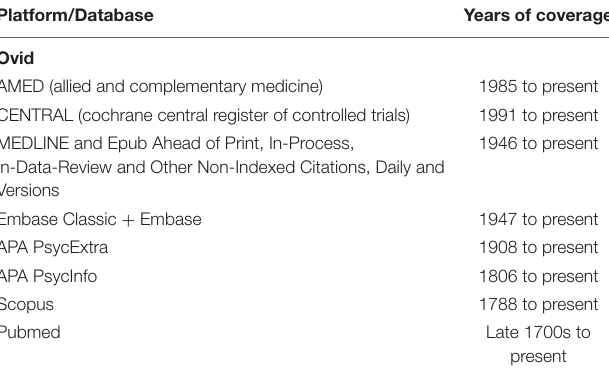
TABLE 1 | Platforms/databases and years of